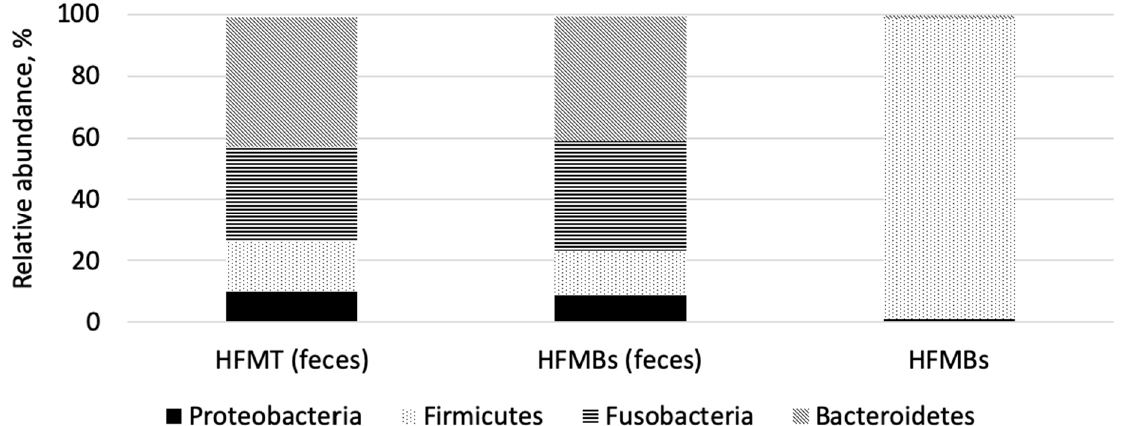
Figure 3. Abundance of Bacteria phyla present in fecal microbiota of dogs consuming diet containing 9.09% Bacillus subtilis hydrolyzed feather meal (HFMBs), 9.09% thermally hydrolyzed feather meal (HFMT), and pure Bacillus subtilis hydrolyzed feather meal (HFMBs). Phyla showed in the figure represents more than 99% of bacteria identified. The other phyla detected are Tenericutes, Verrucomicrobia, Lentisphaerae, Chloroflexi, Deferribacteres, Epsilonbacteraeota, Acidobacteria, and Actinobacteria.